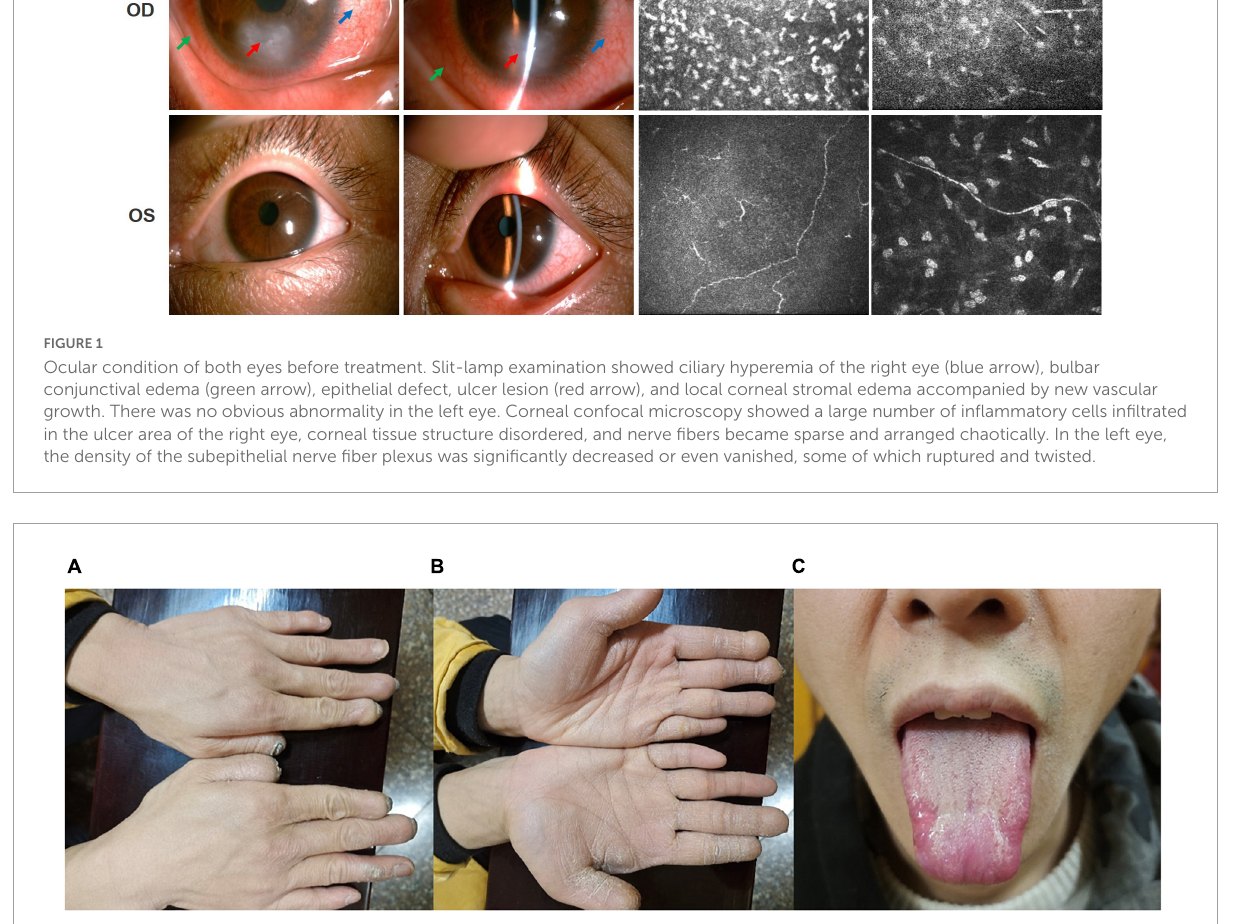
FIGURE2 Systemic manifestations. Clinical symptoms of the patient: Spontaneous amputation of fingertips (A) , dry and hyperkeratotic skin of the palm (B) , damaged tongue (C)